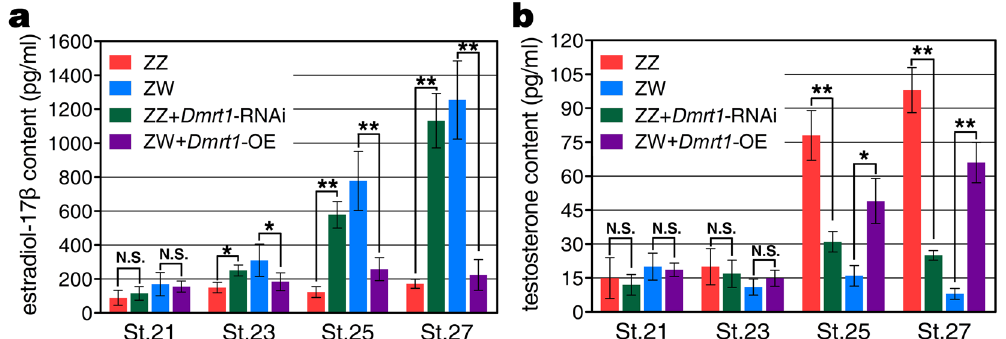
Figure 7. Effects of Dmrt1 knockdown or over-expression on sex steroids production. Estradiol-17 β ( a ) and testosterone ( b ) levels in control ZZ embryos, control ZW embryos, ZZ embryos injected with LV- Dmrt1 - shRNA and ZZ embryos injected with LV- Dmrt1 at different stages. Markedly increased estradiol-17 β and significantly reduced testosterone levels in ZZ embryos with Dmrt1 knockdown, demonstrated the female- biased steroid production in male to female sex reversal. In ZW embryos overexpressing Dmrt1 , the opposite phenomenon were observed, showing the male-biased steroid production in female to male sex reversal. Data are shown as means ± S.D. N ≥ 3. * P < 0.05; ** P < 0.01; N.S., no